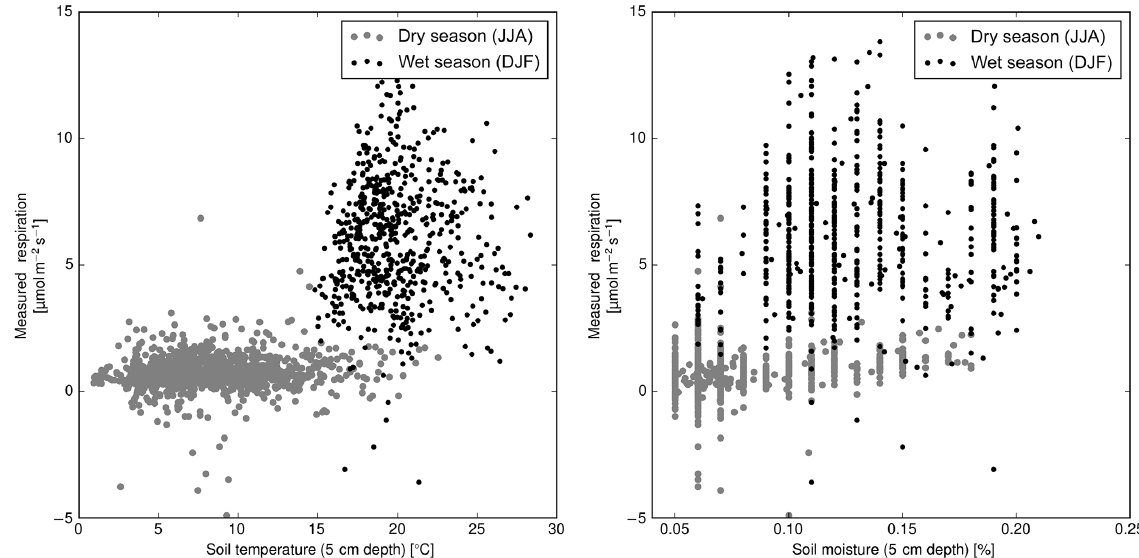
Figure 4. Relationship between night-time respiration and soil temperature (left) and soil moisture (right) for the wet (DJF) and dry (JJA) seasons from September 2010 to August 2011. Night-time was defined as periods when PAR is less than 20µmolm − 2 s − 1 .